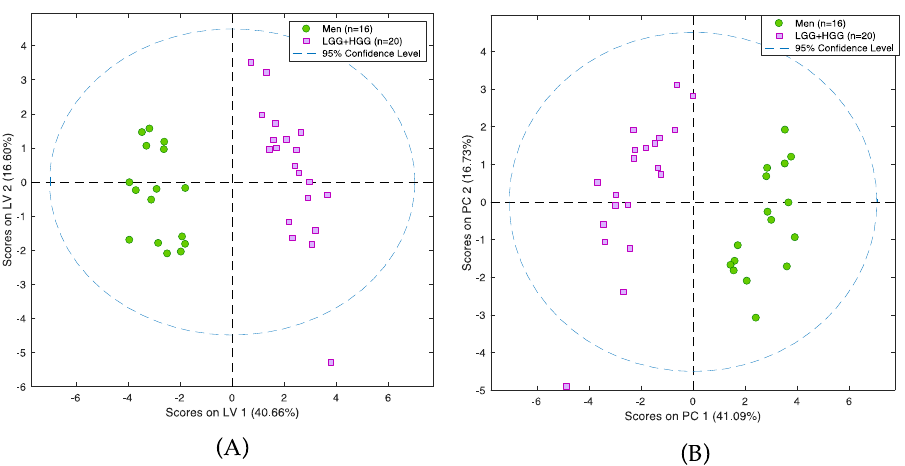
Figure 3. PCA scores plot ( A ) and PLS-DA model ( B ) presenting differences between group of glioma and group of meningioma samples. Pink squares represent patients with meningioma and green circles patients with glioma. Analysis was performed on a PFP column in positive ionization mode.